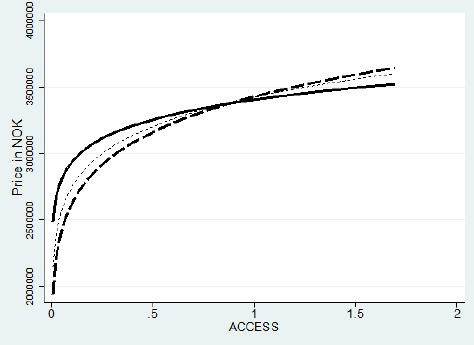
Figure 3: Predicted house prices of a standard house